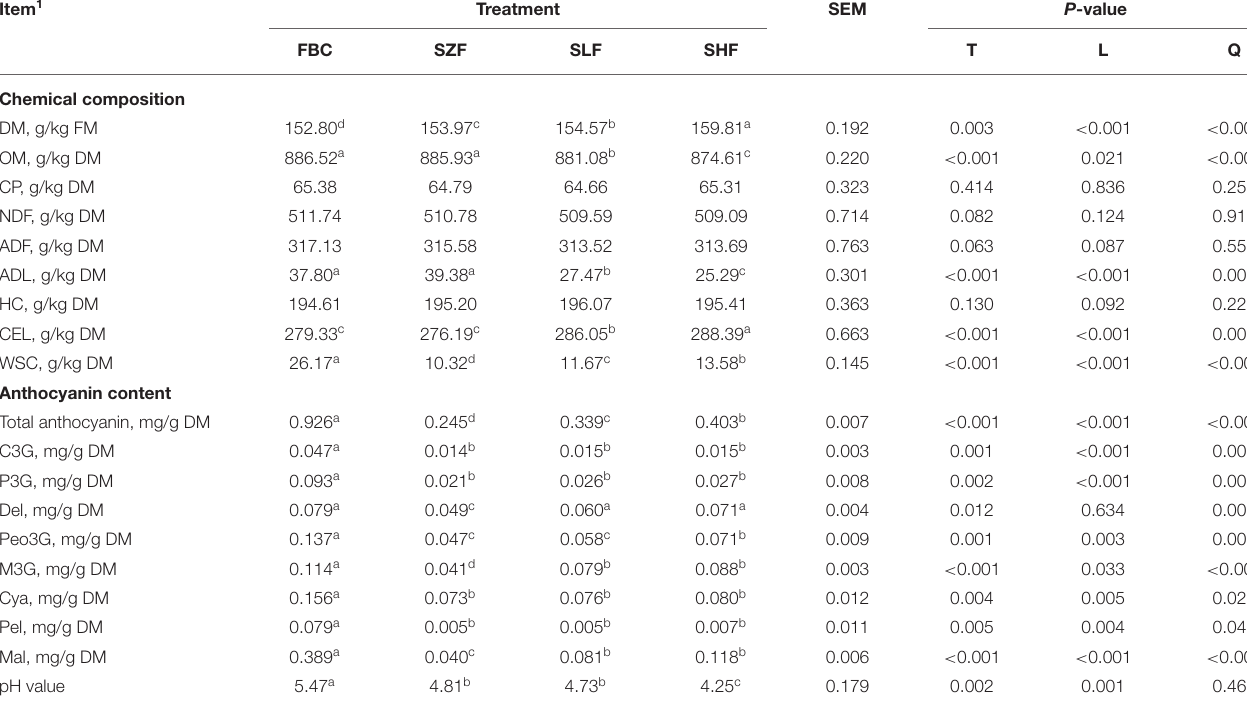
TABLE 1 | Chemical composition, anthocyanin content, and pH value of black cane prior to ensiling (pre-ensiled materials) and silages treated with ferrous sulfate heptahydrate after 21 d. Item 1